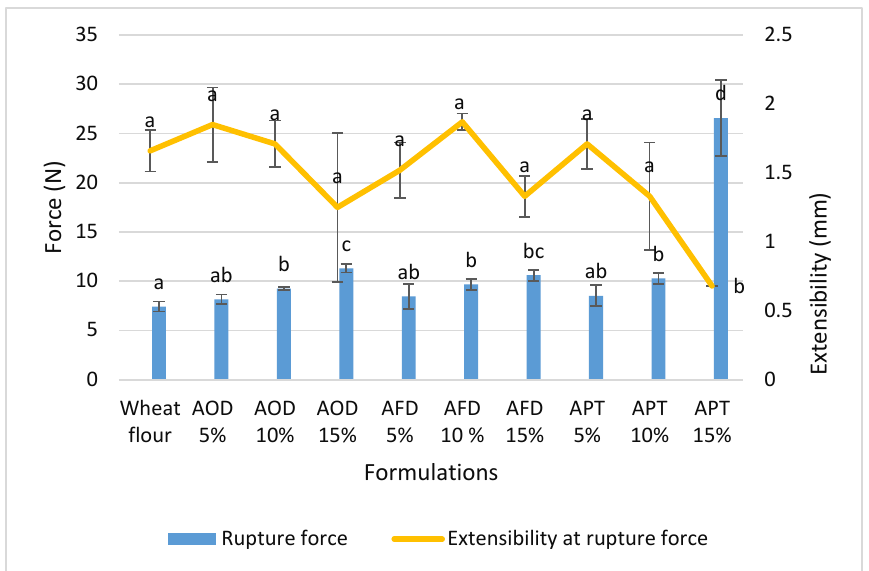
Figure 4. Uniaxial extensibility of baked chapatti. Results are presented as mean of six replicates. Error bars correspond with ± standard deviations. Different letters mean statistically different values ( p < 0.05). AOD = A. domesticus oven dried; AFD = A. domesticus freeze dried; APT = A. domesticus paste.